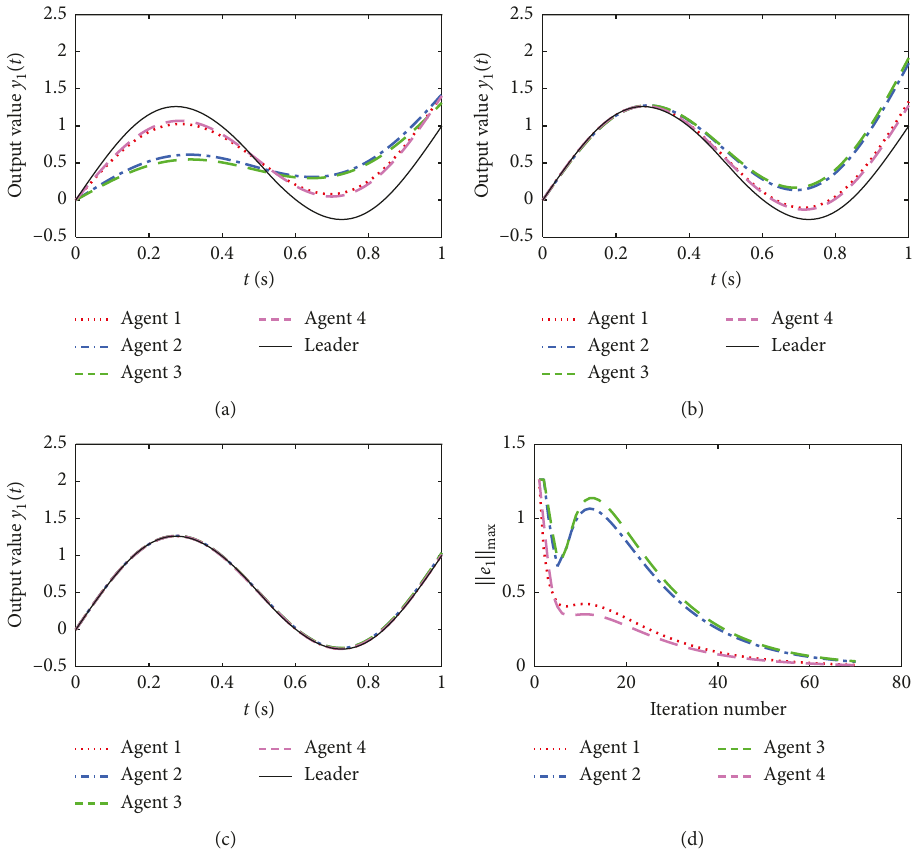
Figure 4: Results of y D α -type FOILC. (a) Trajectories y 1 with open-loop 1 ( t ) at the 5th iteration. (b) Trajectories y 1 ( t ) at the 20th iteration. (c) Trajectories y 1 ( t ) at the 70th iteration. (d) Tracking error e 1 vs. iteration